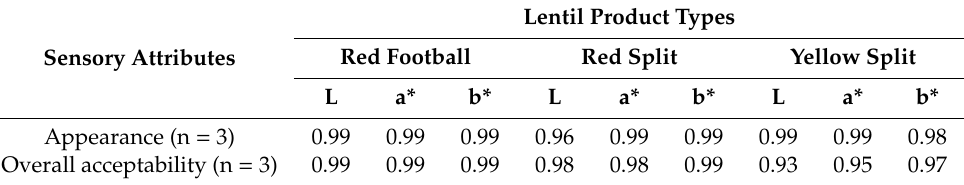
Table 4. Correlation coe ffi cients between colorimetric data lightness (L*), redness (a*) and yellowness (b*) score obtained from HunterLab and sensory acceptability scores from Bangladeshi consumers for three attributes (appearance, and overall acceptability) of each of three uncooked product types (red football, red split and yellow split) of lentil samples. all the correlation coe ffi cients were found significant at p <